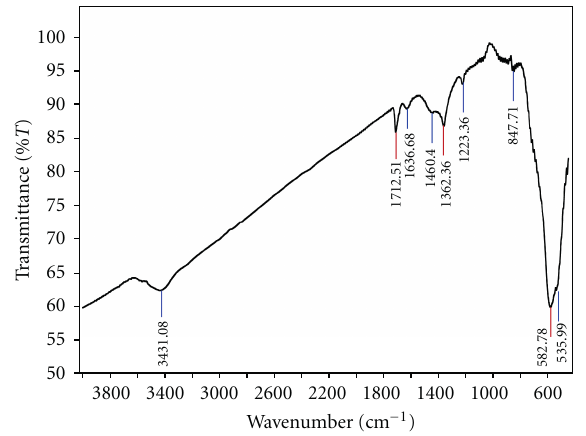
F 4: Transmission electron microscopy (TEM) image of mixed